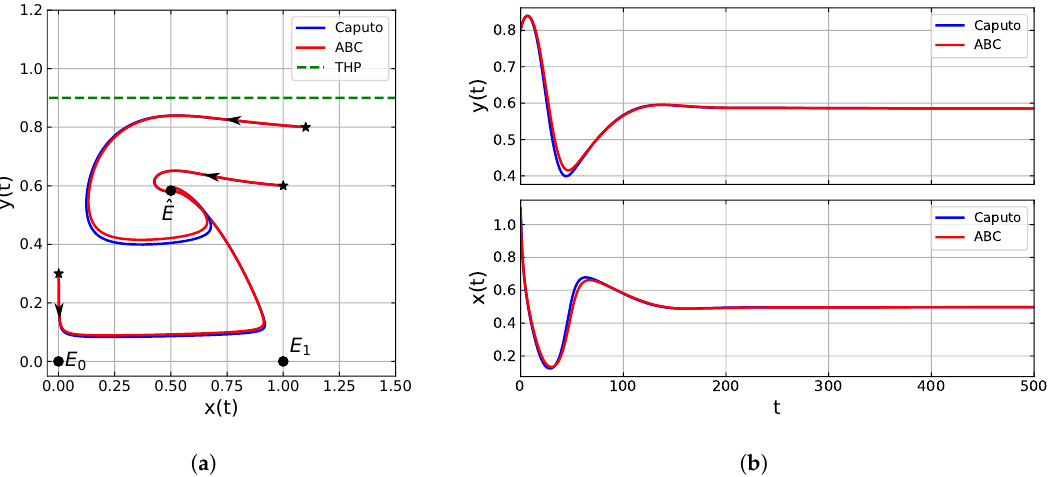
Figure 3. Numerical simulations of Caputo model (6) and ABC model (16) with parameter values (29) and n = 0.14: Figure ( a ) phase portrait; and Figure ( b ) time series.